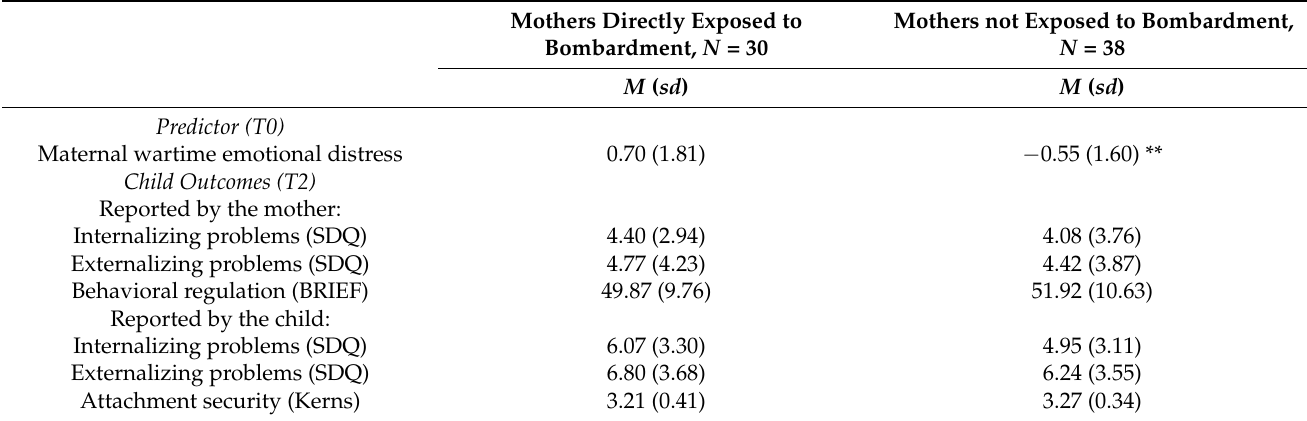
Table 2. Descriptives of the study